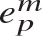
Dependence of the coefficients ψ1 (panel A) and ψ2 (panel B) on the power-law disc model represented by the indices p and p + q, respectively. Panel C shows the amplitude epm of eccentricity oscillations (normalized by disc eccentricity ed) induced by disc gravity. Results for softened formalisms of Hahn (2003) (in red), Touma (2002) (in blue) and Tremaine (1998) (in green) are computed using softening ς = 10−3. Calculations assume infinitely extended disc (i.e. no edge effects). For reference, open black circles show the profiles of ψ1, ψ2 and epm as computed by SR15: curves for Hahn (2003) and Touma (2002) fall on top of them, while those for Tremaine (1998) show constant offset in terms of both ψ1 and ψ2 (illustrated by scale bars in panels A,B) resulting in deviation between epm curves (panel C).